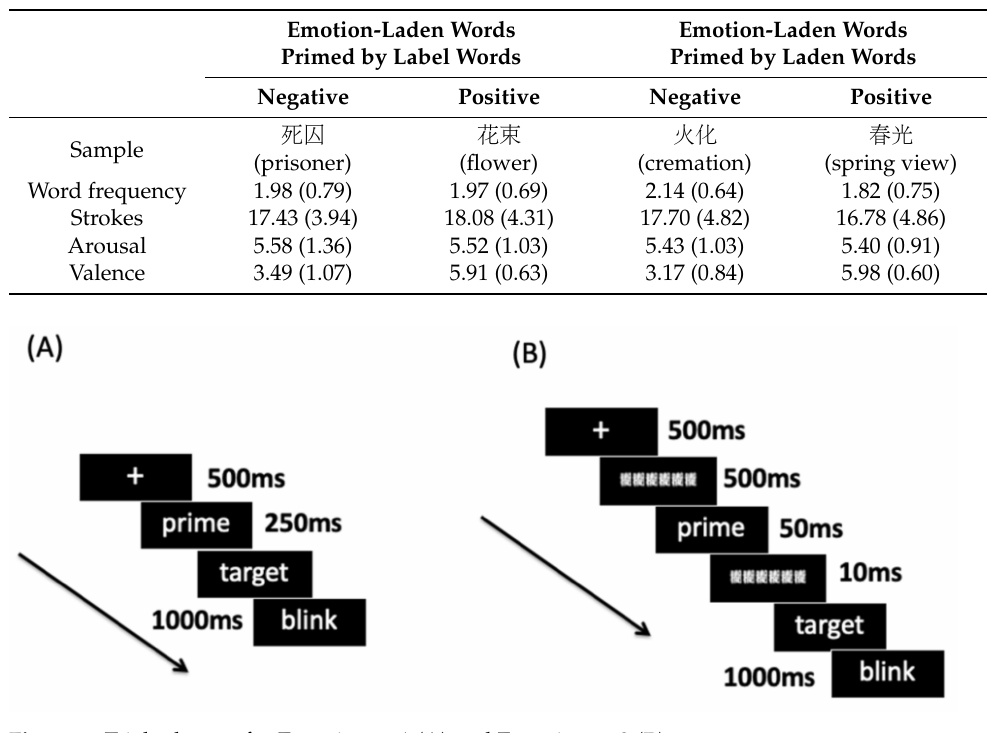
Figure 1. Trial schemes for Experiment 1 ( A ) and Experiment 2 ( B